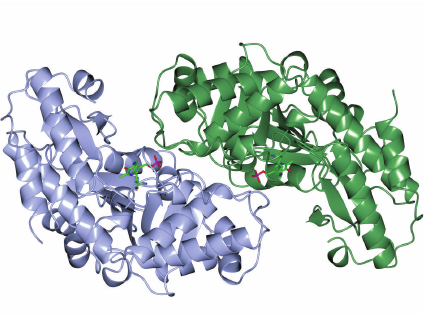
Figure 1: A ribbon diagram of the structure of the Sulfolobus transaminase dimer showing each monomer in a different colour as viewed along the molecular twofold axis. The cofactor pyridoxal phosphate (PLP) is shown bound to the active site lysine as a stick model in the two active sites (PDB code 3ZRP). The figure was constructed using CCP4mg [53].